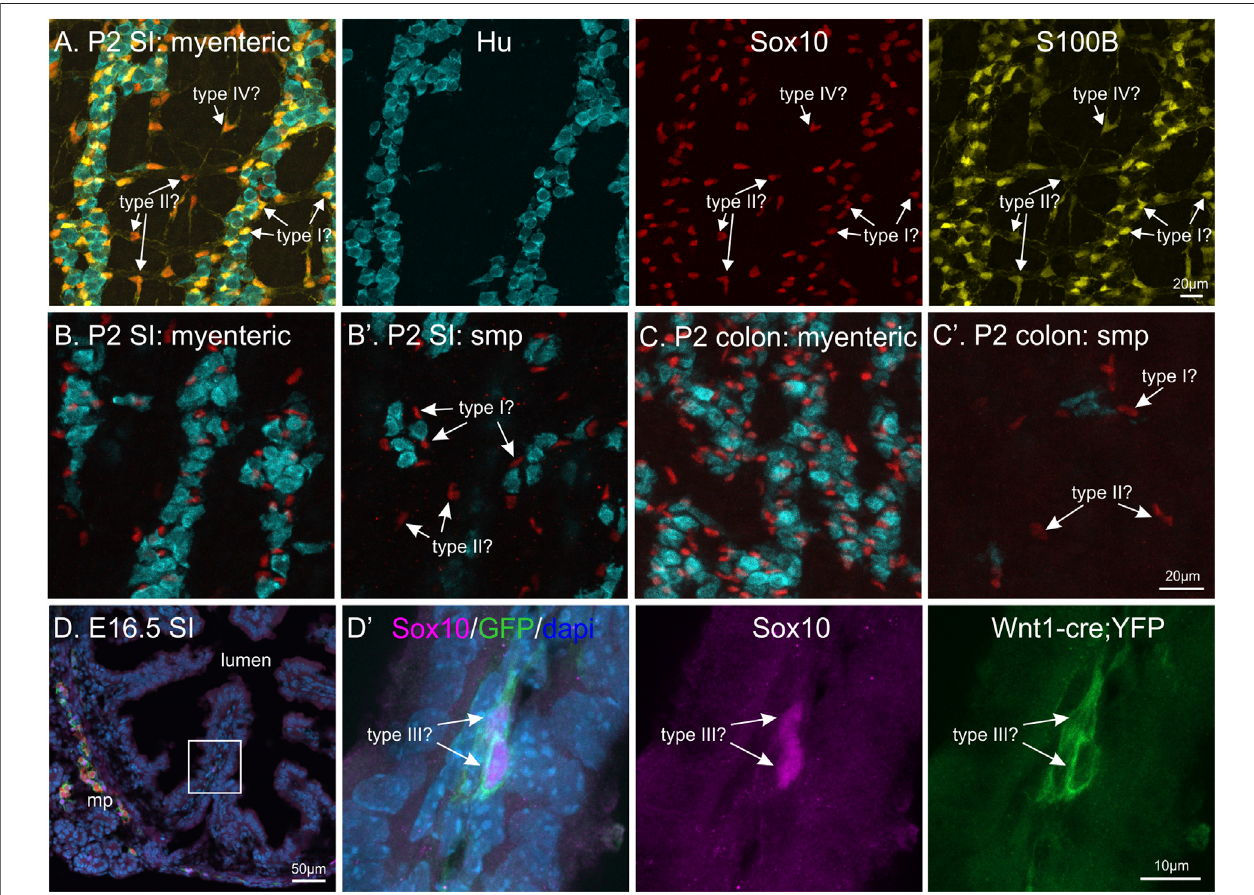
FIGURE 4 | Differentiation of enteric glial subtypes during ENS development? (A – C) : Whole-mount postnatal day 2 (P2) murine gut with immunohistochemical staining against HuC/D (blue), Sox10 (red) and S100B (yellow). By P2, enteric glia are present in different locations in the various gut layers: in the myenteric and submucous(smp,arrows)plexusinboththesmallintestine(SI)andcolon,andalsosurroundingneuronswithinganglia.Shouldtheseentericgliabeclassi fi edastypeI,II, III or IV based on their locations? (D) : Transverse cryosection of E16.5 small intestine from Wnt1-cre;R26R-YFP mice, where all neural crest-derived cells express YFP. Immunohistochemical labelling against Sox10 (magenta), HuC/D (red), YFP (green) and dapi (blue) was performed. Inset on left image is magni fi ed in the following panel. Sox10+ cells can be observed in some villi (arrows), these could be classi fi ed as either type III enteric glia or progenitor cells.